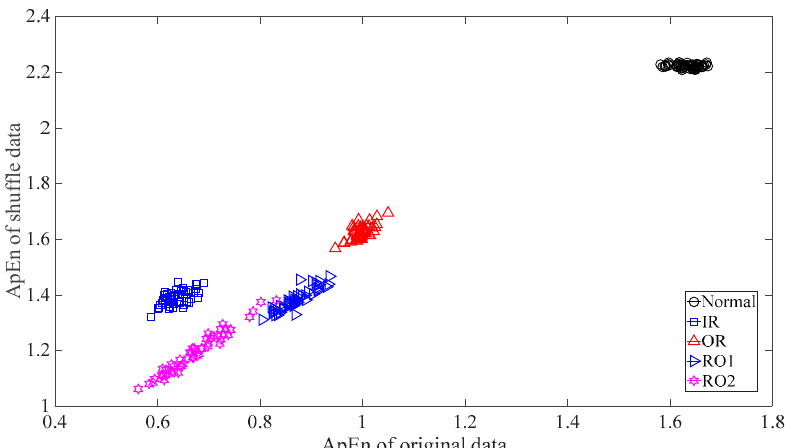
Figure 22. Binary ApEn of the original and shuffle versions of the five types of roller-bearing vibration data.